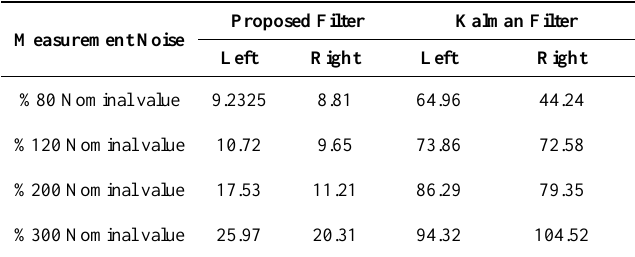
Table 3. Consideration of proposed filter in the third